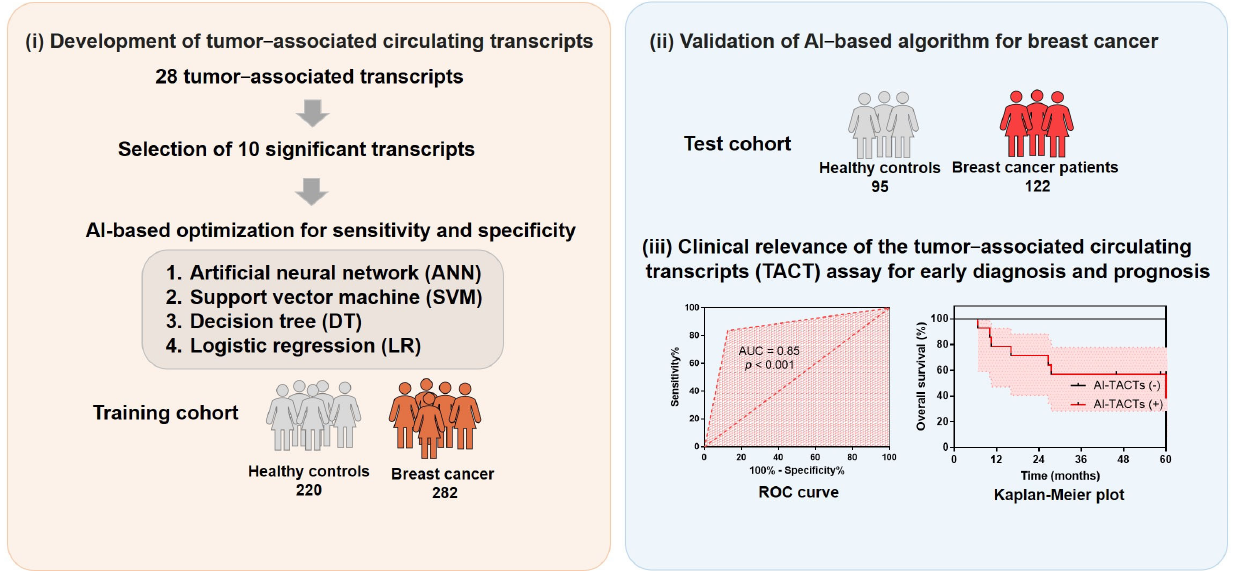
Figure 1. Developmental strategy. Study design for the development and validation of the tumor- associated circulating transcript (TACT) assay.